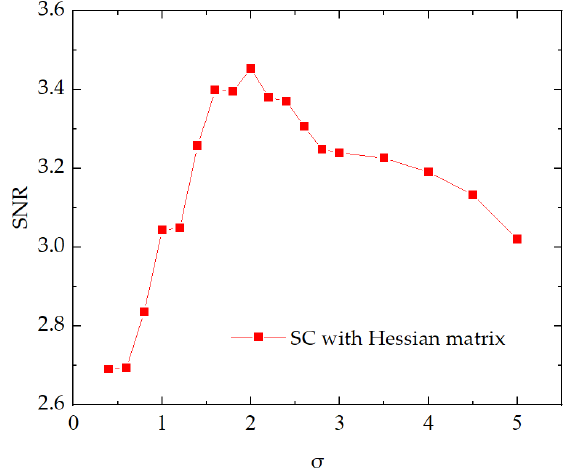
Figure 8. The SNR of a reconstructed image of SC with the Hessian filter in different values of standard deviation.